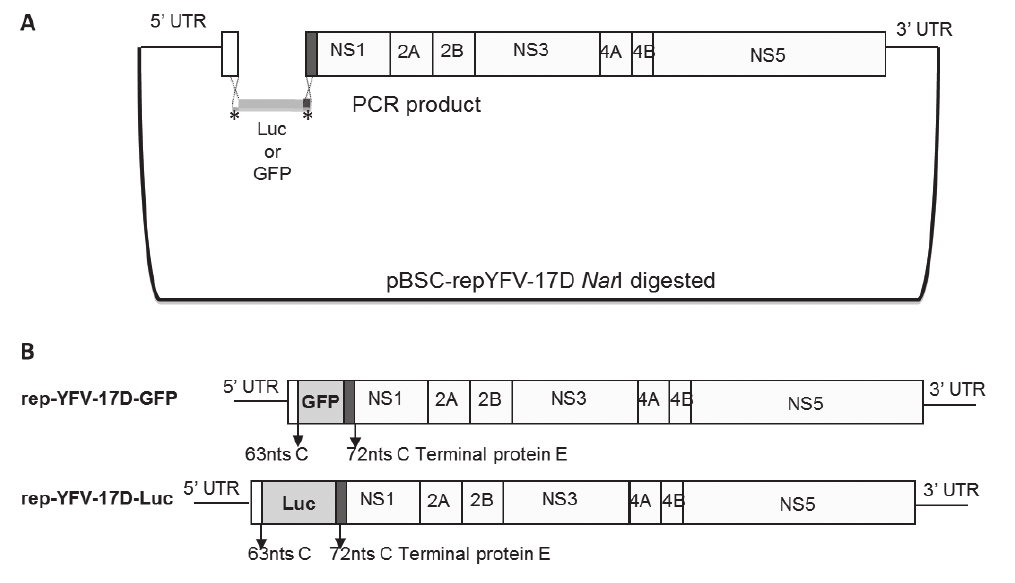
Figure 1- Schematic representation of construction of subgenomic replicons repYFV-17D-GFP and repYFV-17D-Luc. (A) Homologous recombination in yeast between a PCR product containing Luc or GFP gene and the vector pBSC-repYFV- 17D NarI digested. The PCR product is represented with a sequence identification. (B) Genome organization of subgenomic replicons repYFV-17D-GFP and repYFV-17D-Luc. * Homologous sequences (25 nts) for yeast